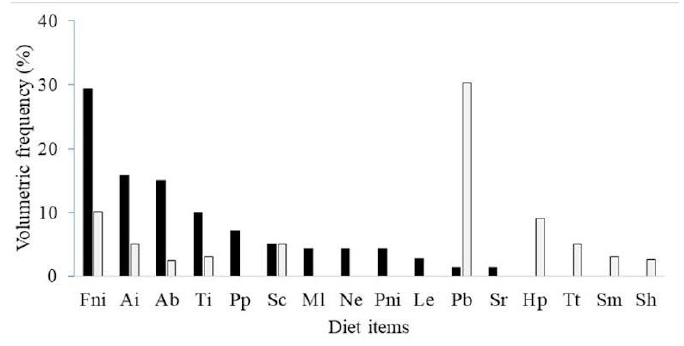
Figure 5. Volumetric data (%) of the gut contents of P. squamosissimus in preserved area (black bar) and impacted area (gray bar), in Machado River (Brazilian Amazon), from June 2013 to March 2015. Fni = Fish no identified; Ai = Aquatic insects; Ab = A. bimaculatus ; Ti = Terrestrial insects; Pp = P. pardalis ; Sc = Scales; Ml = M. lepidura ; Ne = Nematodes; Pni = Plant no identified; Le = Leaves; Pb = P. blochii ; Sr = S. rhomabeus ; Hp = H. plecostumus ; Tt = T. trimaculatus ; Sm = S. macrurus ; Sh = Shrimp.